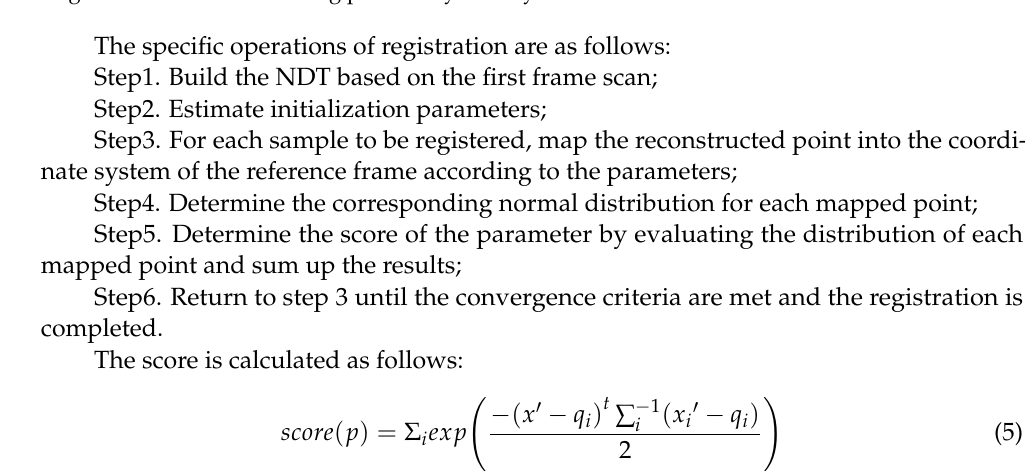
Figure 2. The original data and the resulting probability density: ( a ) mesh the point cloud; and ( b ) the original scan and the resulting probability density.